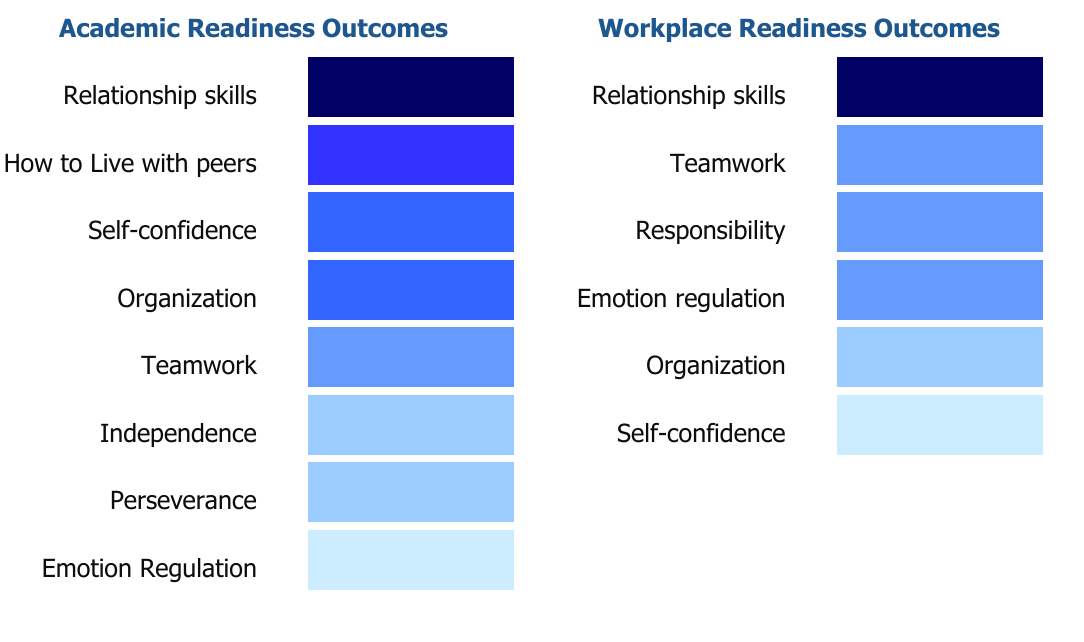
Figure 1. Academic and Workplace Readiness